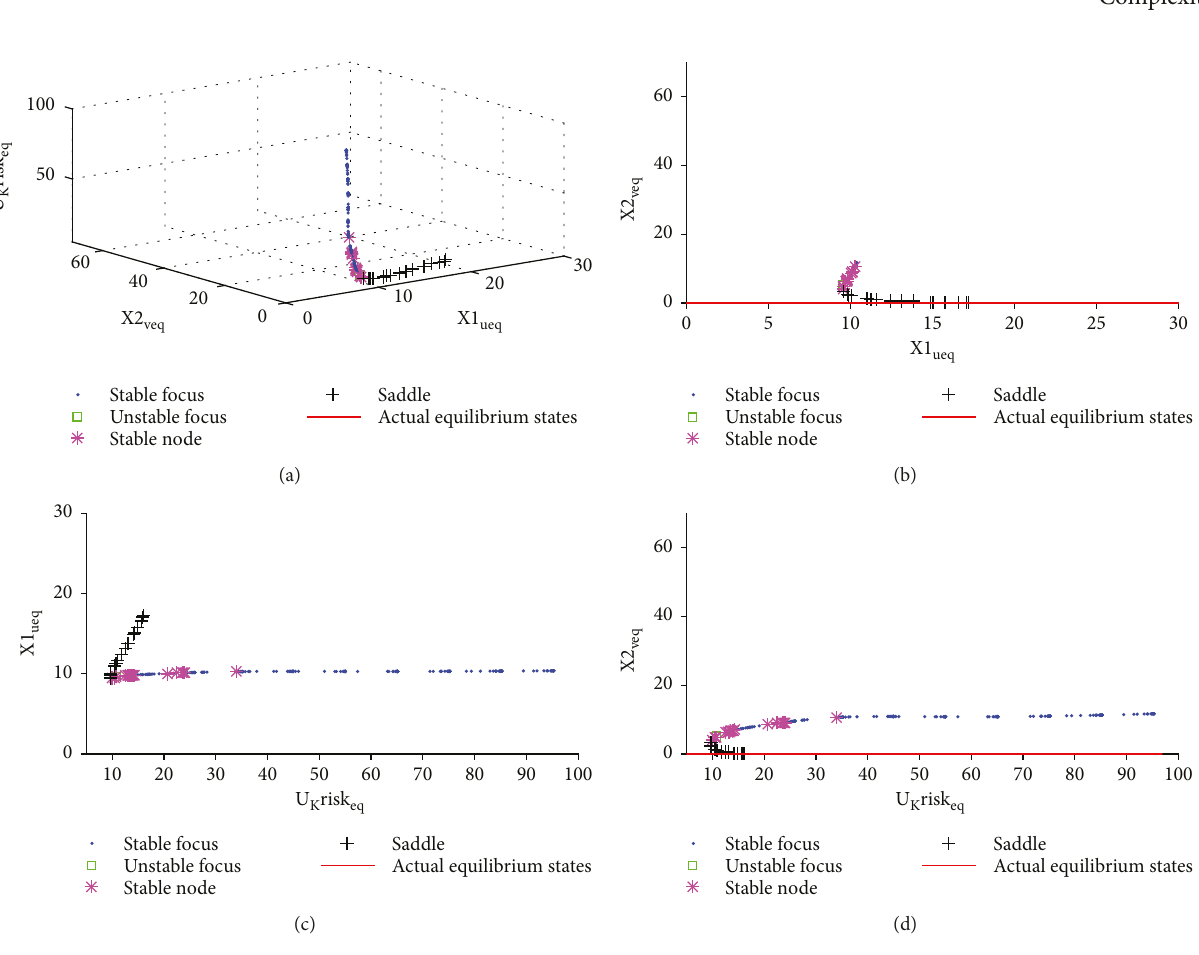
Figure 7: Equilibrium states of the predator-prey NN